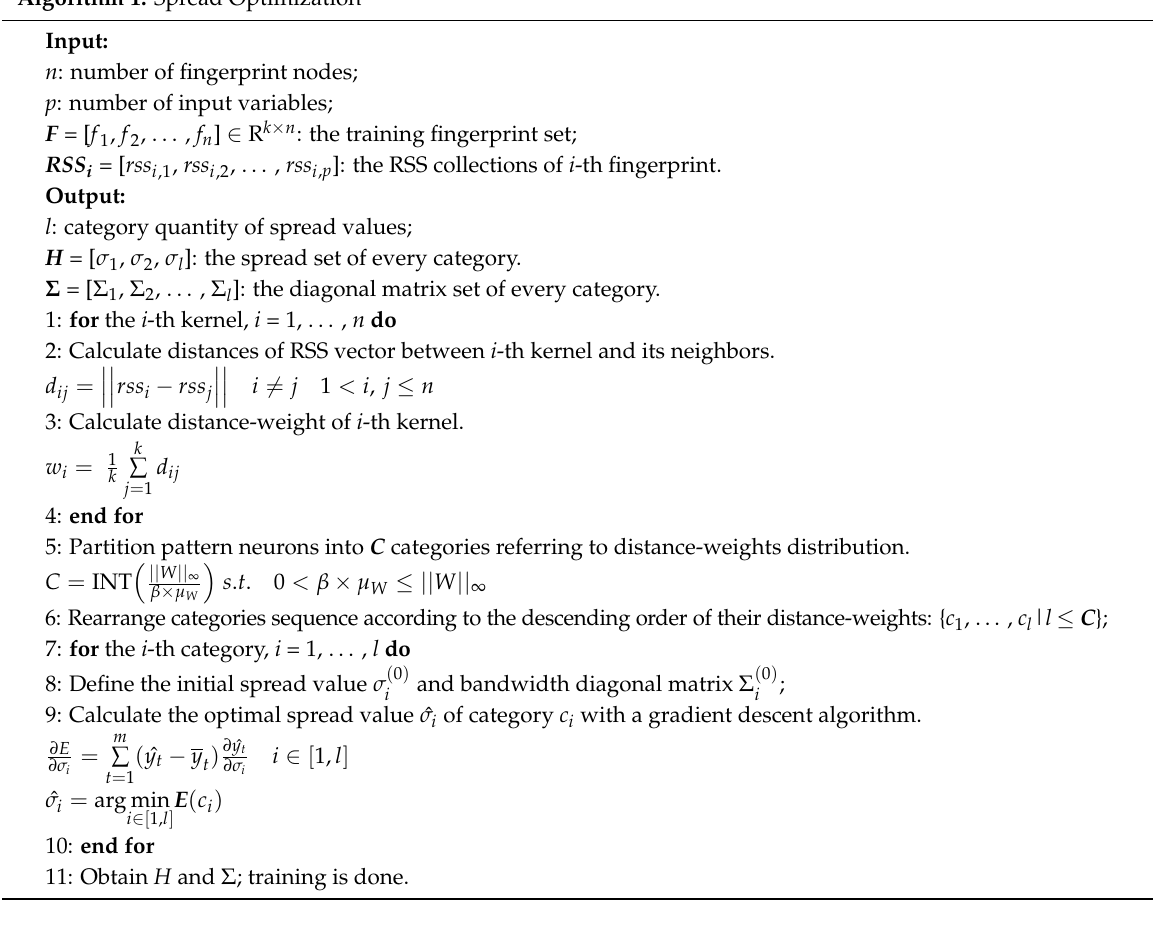
Algorithm 1. Spread